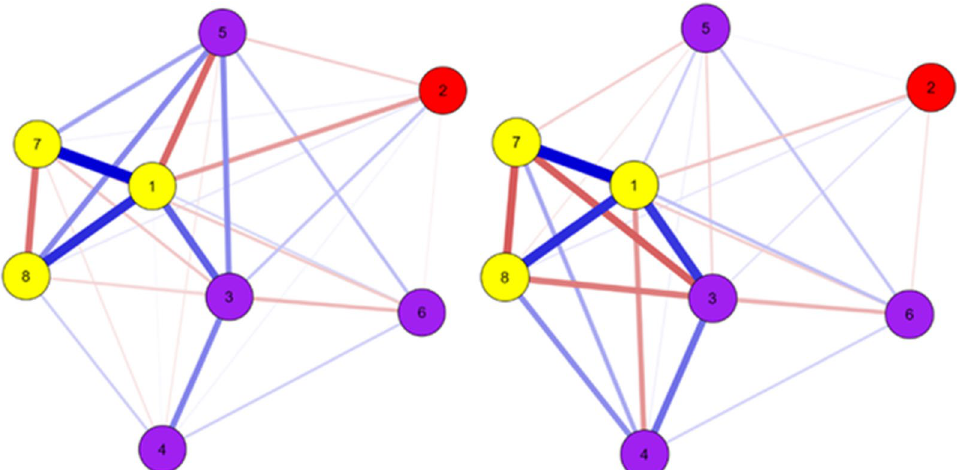
Fig. 1 Network plot for both sexes (left panel: women; right panel: men). Legend: yellow colors—(1) training volume/week; (7) training frequency/ week (> 3 train/week); (8) Running experience (> 1 year); purple colors—(3) running event (yes); (4) running group participation (yes); (5) runner in family (yes); (6) sports childhood participation (yes); red color—(2) running pace (s/km)